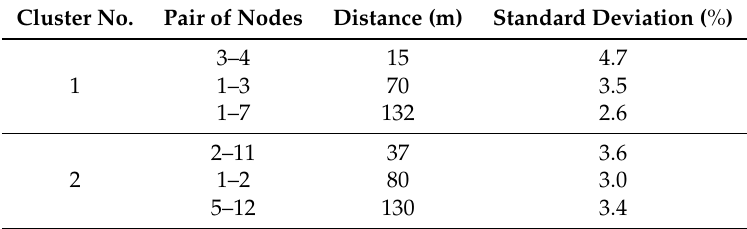
Table 6. Standard deviation of 6 pairs of nodes characterized by different inter-node distances (Roncovetro). Cluster